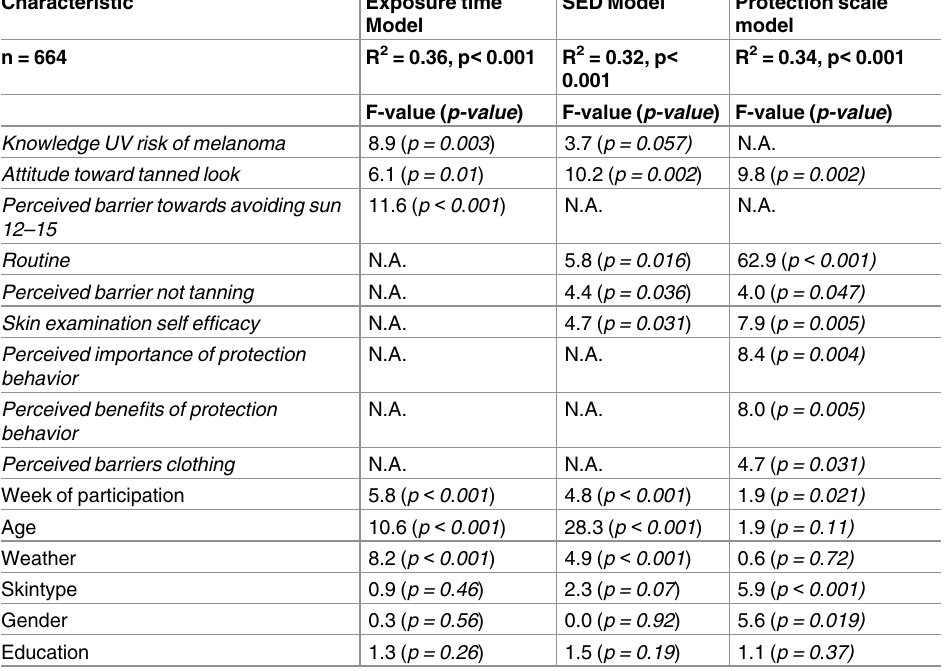
Table 3. Linear regression models of outdoor exposure time, UV-exposure receivedin SED and the protection scale